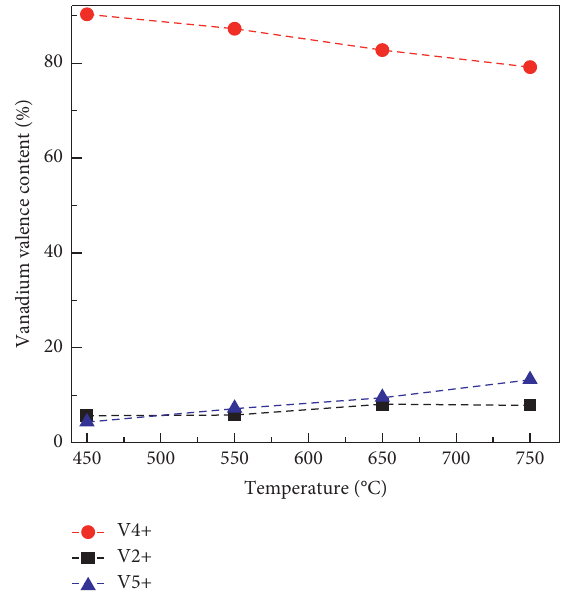
Figure 1: Vanadium valence in the PLD-grown VO